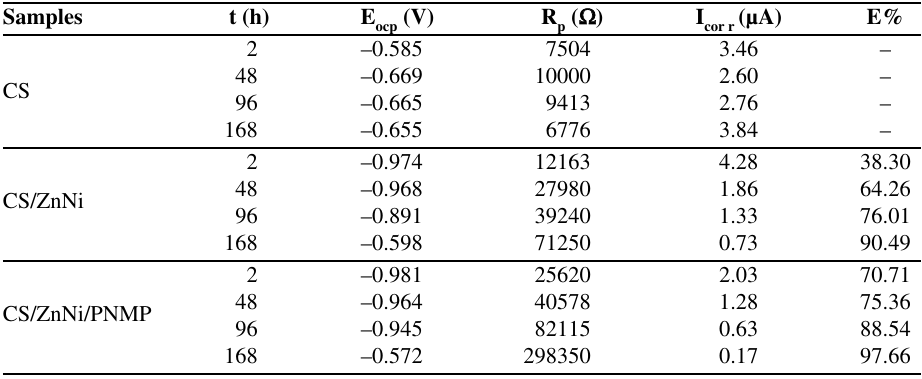
Table 1. The R , E , I and E% values recorded for CS, CS/ZnNi and CS/ZnNi/PNMP electrodes after va- p ocp corr rious exposure times in 3.5% NaCl. Samples